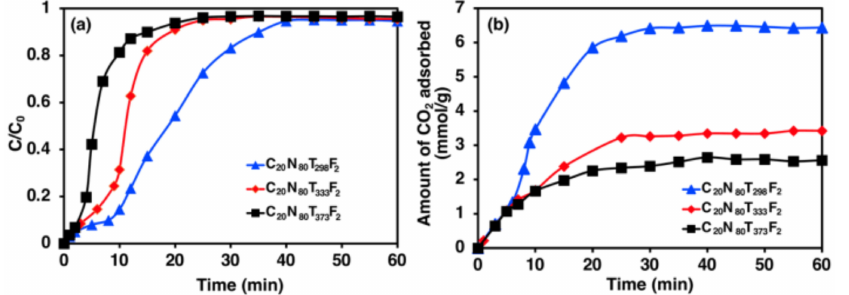
Figure 3. Effect of temperature on CO 2 adsorption at feed flow rate of 2 L/h, which represented as: ( a ) breakthrough curves; ( b ) adsorption